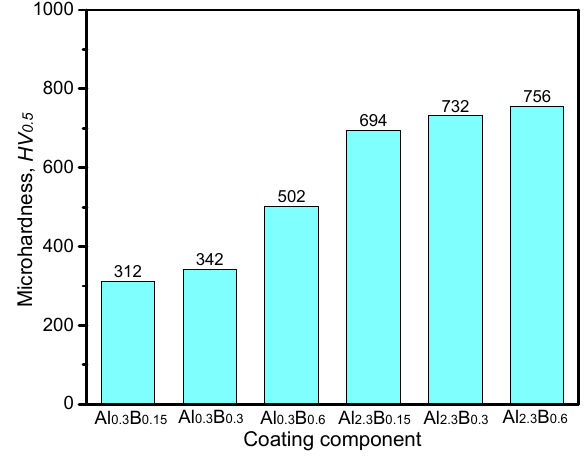
Figure 4. The average microhardness in the center of the Al x B y HEA coatings.